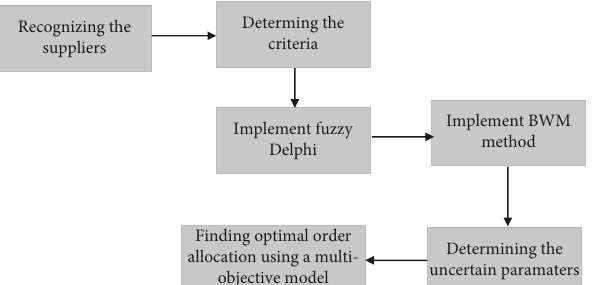
Figure 2: The proposed framework based on MCDM and MODM to evaluate the